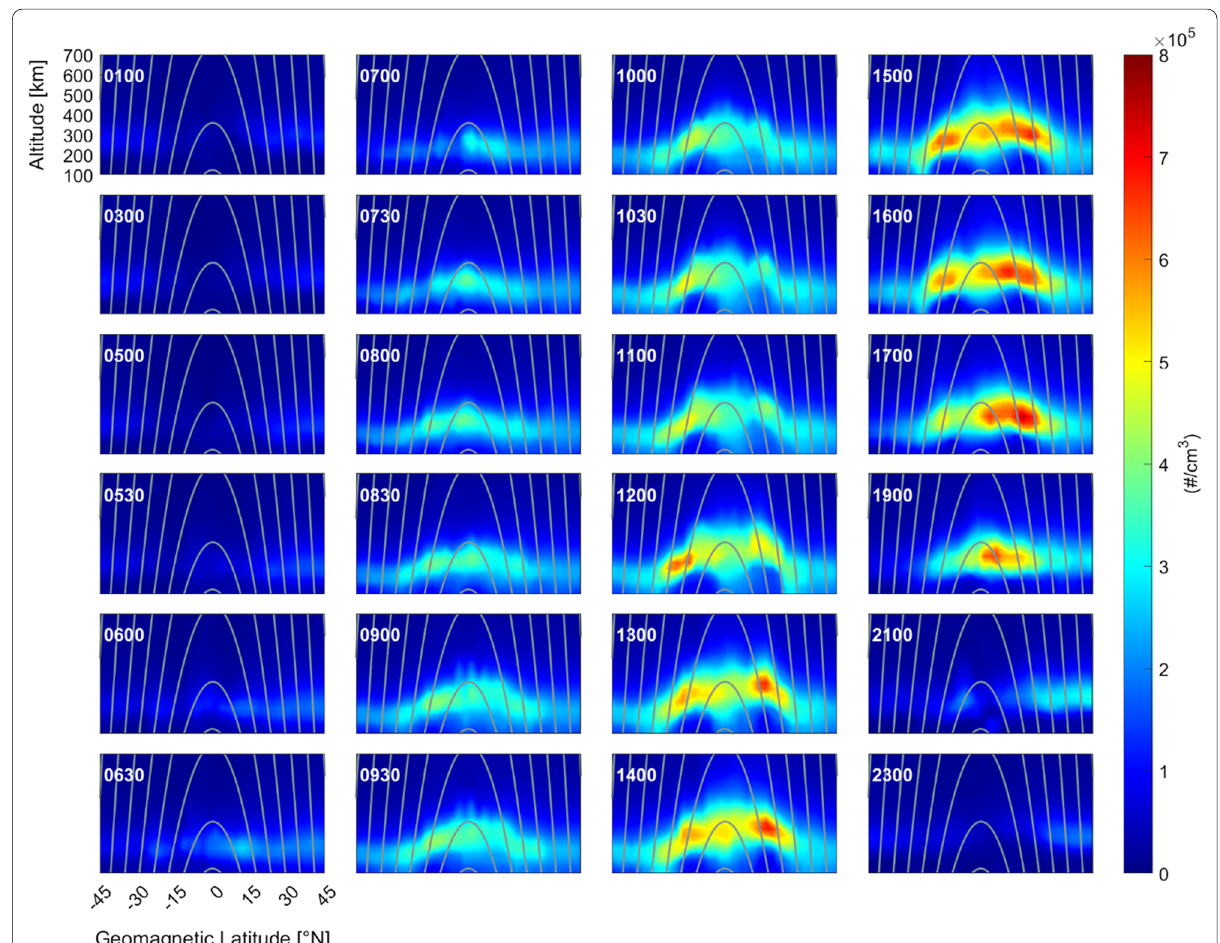
Fig. 2 Time evolution of the ionospheric plasma density structure at the mid‑ and low‑latitude regions at around 120°E meridian sector. The plasma density structures plotted at each local‑time interval is constructed by taking the median of the F3/C observations within a two‑hour period in June 2009. The binning method is same as that for Fig. 1. White curves stand for the magnetic field